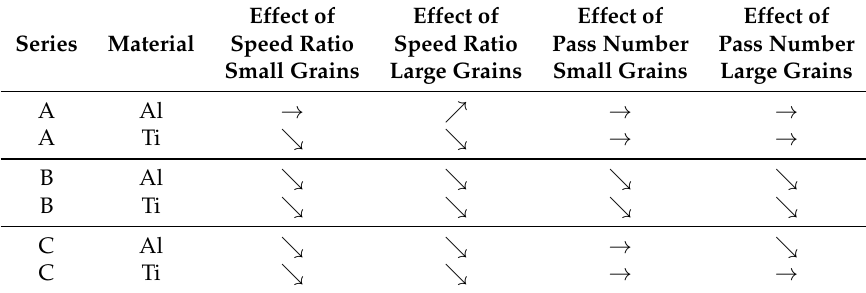
Table 1. Qualitative evolution of the grain size during DSR responding to increasing speed ratio and increasing DSR pass number. (A) single material sheets; (B) five-layered composite sheets; (C) 160-layered composite